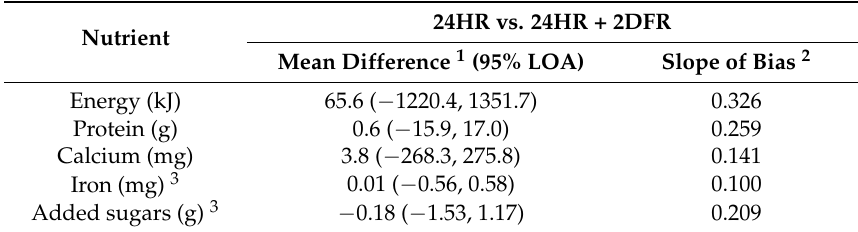
Table 2. Bland–Altman statistics comparing intake of key nutrients from the 24HR and 24HR + 2DFR in Australian toddlers aged 12 months ( n =